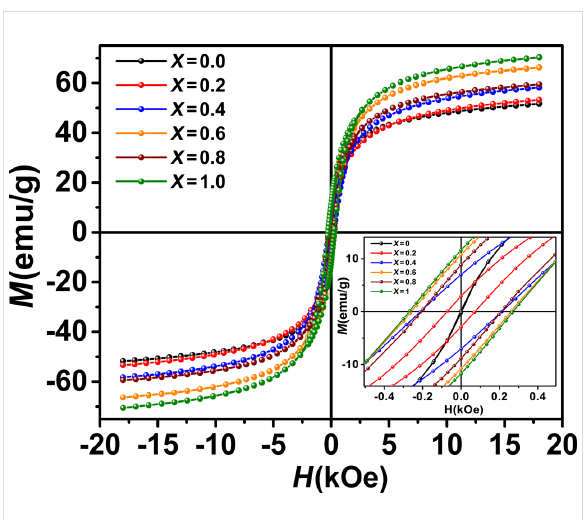
Figure 8: Room-temperature magnetization curves of the Co x Fe 3 − x O 4 samples measured. The inset shows the magnetization behavior at low